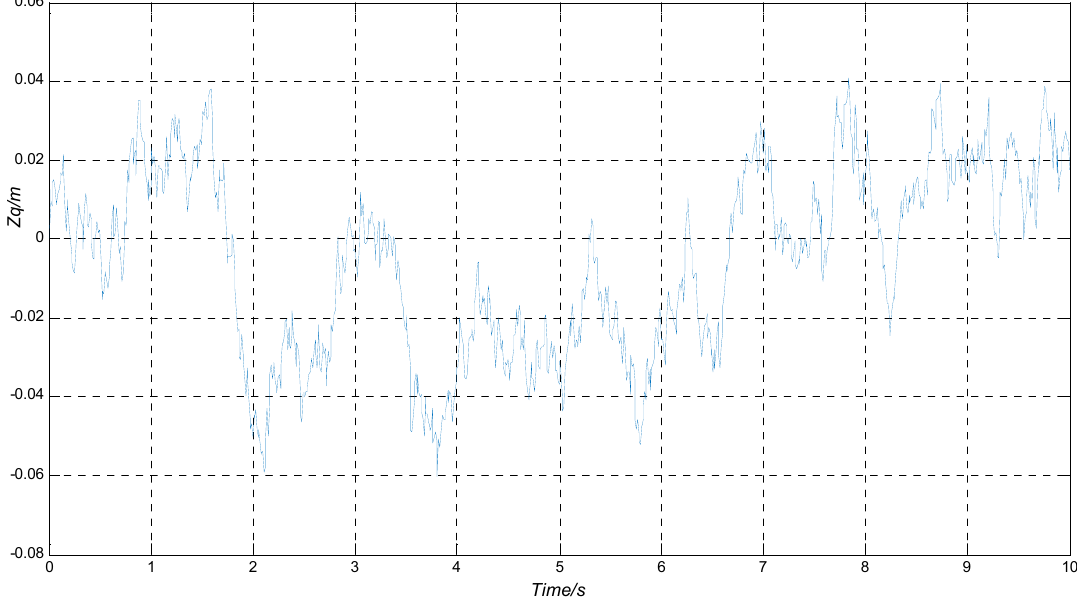
Figure 4. The input displacement of the level C road in this paper.